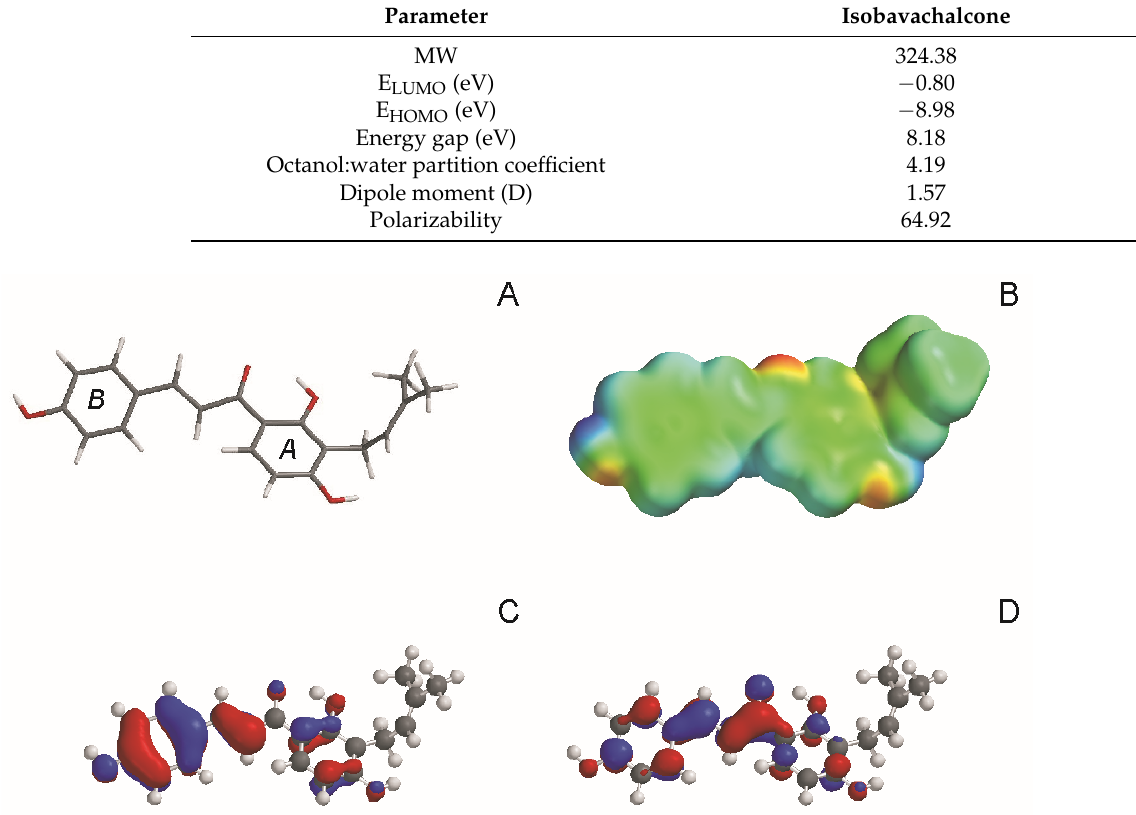
Figure 6. The ball and stick presentations of the optimized structure of IBC ( A ); electrostatic potential map of IBC ( B ) in aqueous solution (the blue color represents the positive region, and the red color represents the negative region); HOMO ( C ) and LUMO ( D ) orbitals of IBC in aqueous solution. All the images were obtained using Titan software.